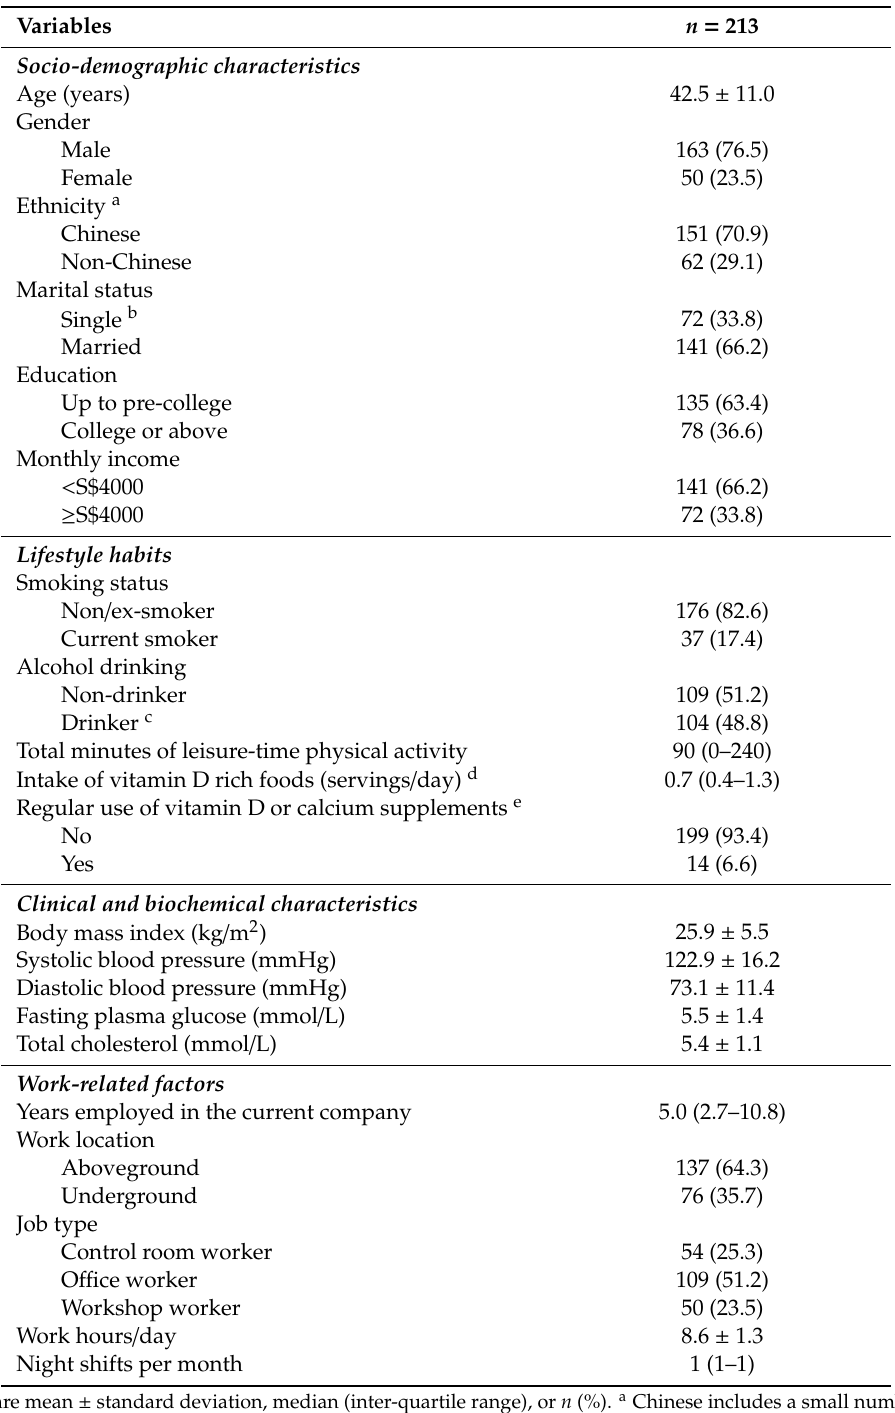
Table 1. Characteristics of the study